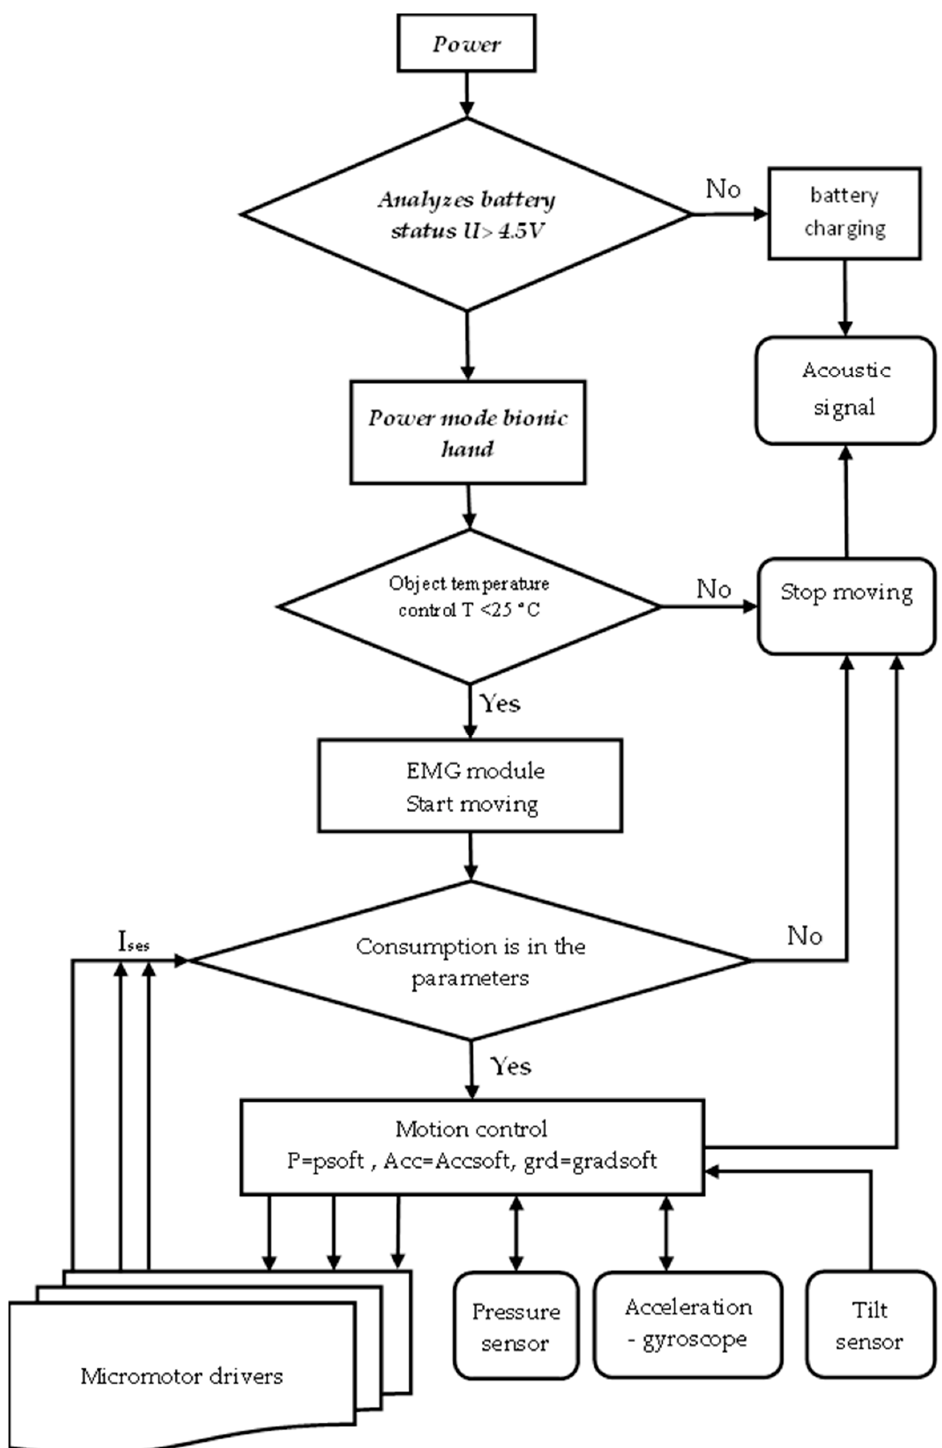
Figure 6. The algorithm scheme of the upper limb.